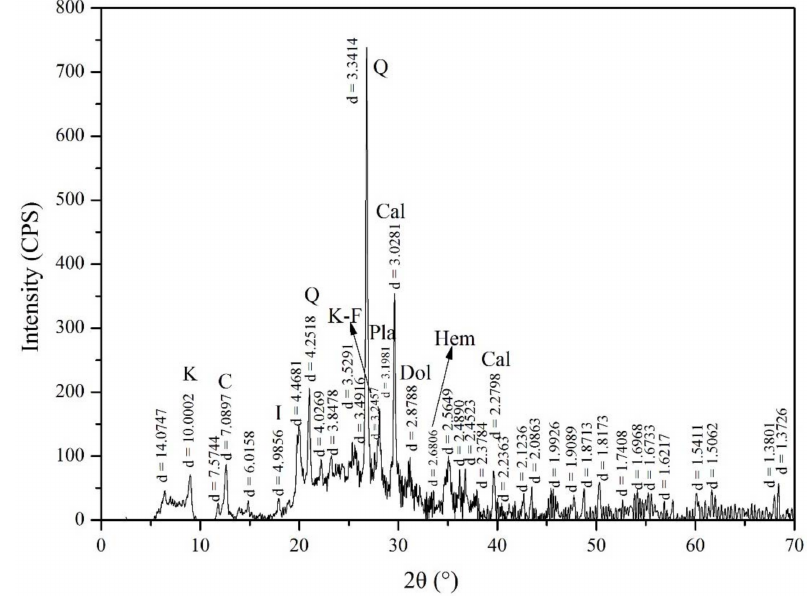
Figure 4. XRD pattern of PM 10 collected during the dust storm. I, illite; K, kaolinite; Q, quartz; C, chlorite; Cal, calcite; Dol, dolomite; K-F, potassium feldspar; Pla, plagioclase; Hem,